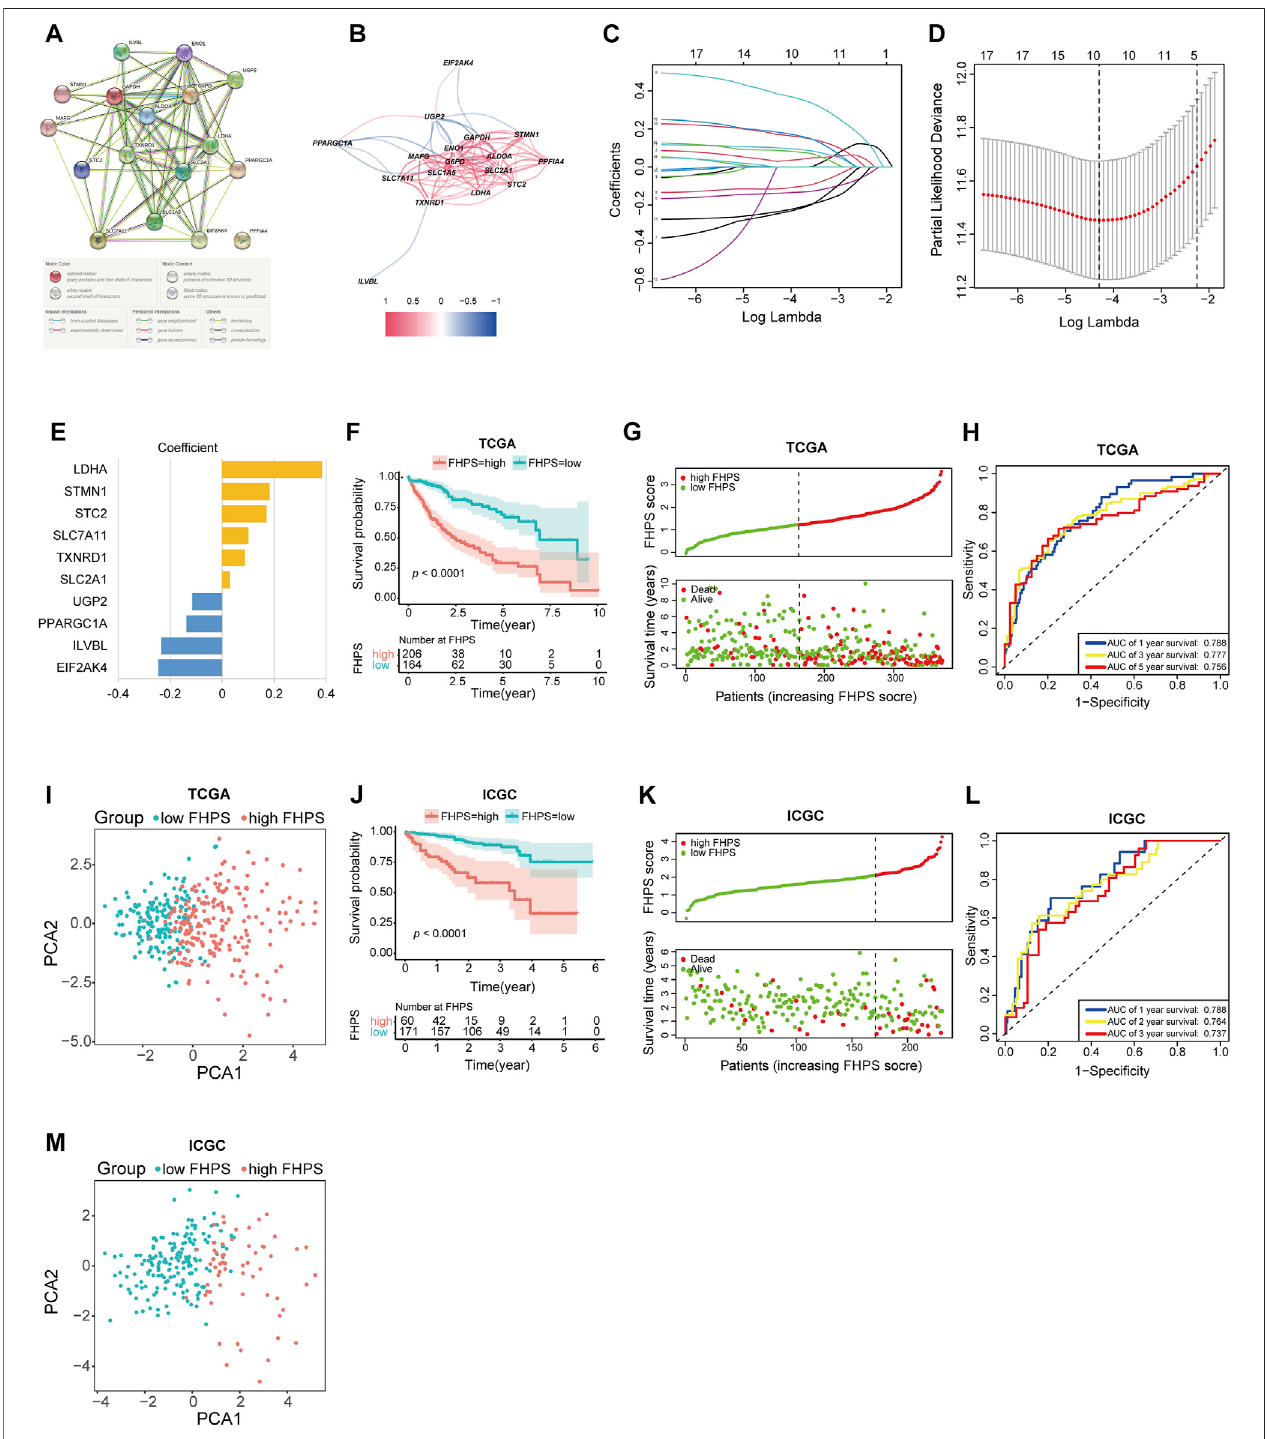
FIGURE 2 | (A, B) The PPI and correlation network suggesting the relationship between prognostic FRGs and HRGs. (C – E) LASSO regression was performed, calculatingthecrucialgenes (C,D) and coef fi cients (E) . (F) Kaplan – Meier curves showed thatthehigh-FHPS group had worseoverallsurvivalthanthelow-FHPS group inTCGAcohort. (G) DistributionsofFHPSscoresandsurvivalstatusofHCCpatientsintheTCGAcohort. (H) ROCcurvesofFHPSforpredictingthe1/3/5-yearssurvival in the TCGA cohort. (I) The plots of the PCA of the TCGA cohort based on the expression pro fi les of the 10 signature genes in different FHPS groups. (J) Kaplan – Meier curves showing that the high-FHPS group had worse overall survival than the low-FHPS group in the ICGC cohort. (K) Distributions of FHPS scores and survivalstatusofHCC patients inthe ICGC cohort. (L) ROCcurvesofFHPS for predicting 1/2/3-years survival inthe ICGC cohort. (M) The plots ofthe PCA ofthe ICGC cohort based on the expression pro fi les of the 10 signature genes in different FHPS